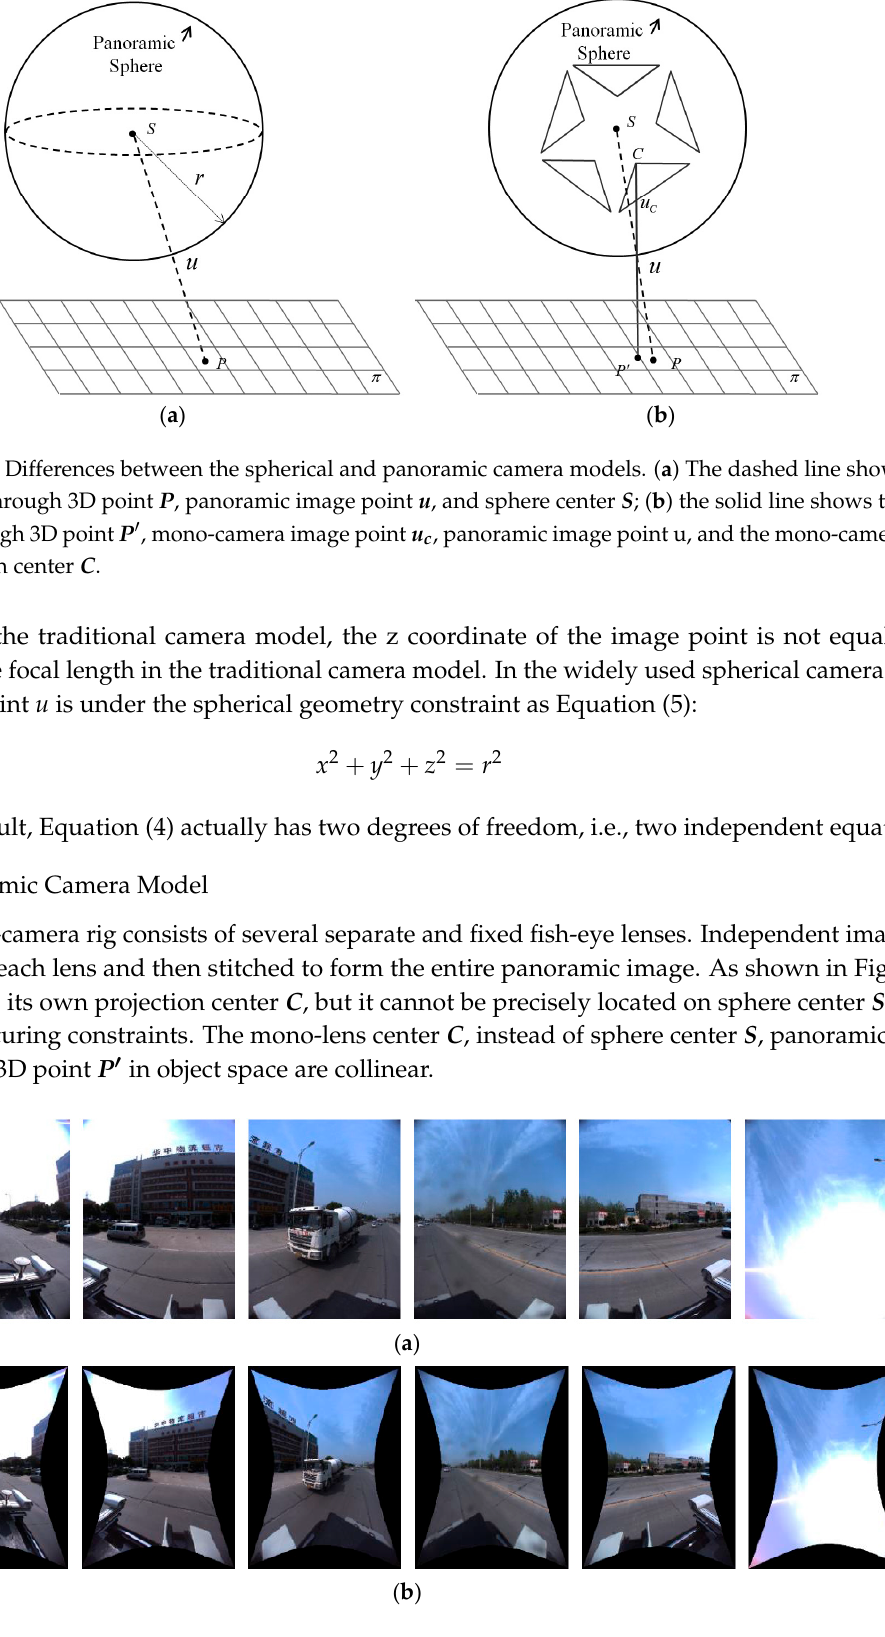
Figure 5. Images of Camera 0–5: ( a ) 6 fish-eye images; ( b ) 6 rectified images. (The meaning of the Chinese characters on the building is Supermarket for Logistics in Central China)